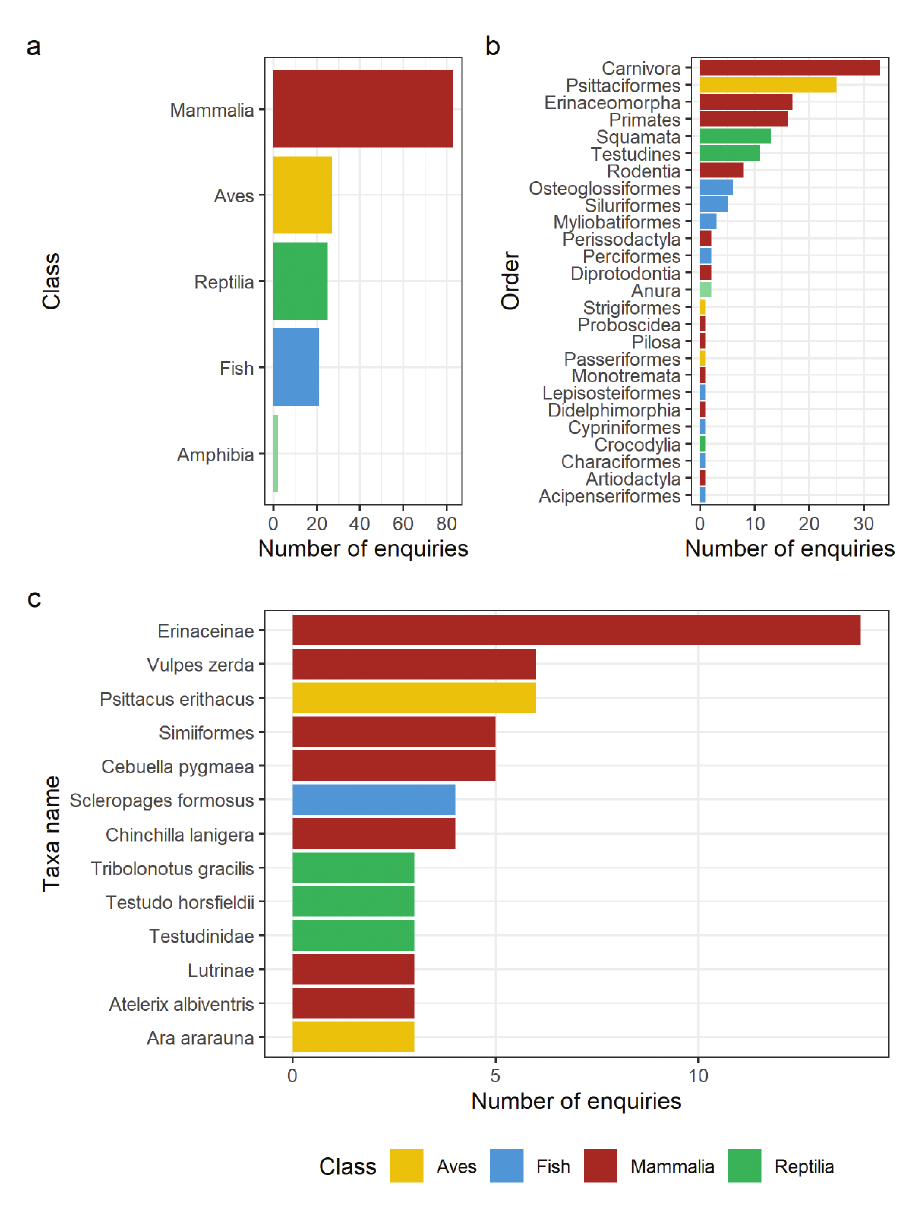
Figure 3. The number of enquiries by taxonomic class ( a ) and order ( b ) and highest taxa specified ( c ), excluding invertebrates. The subfamily Erinaceinae includes hedgehogs, Vulpes zerda is the fennec fox, Psittacus erithacus is the African grey parrot, order Simiiformes refers to monkeys, Cebuella pygmaea is the pygmy marmoset, Scelropages formosus is the Asian arowana, Chinchilla lanigera is the long-tailed chinchilla, Tribolonotus gracilis is the red-eyed crocodile skink, Testudo horsfieldii is the Russian tortoise, the family Testudinidae includes tortoises, the family Lutrinae include otters, Atelerix albiventris is the four-toed hedgehog and Ara ararauna is the blue-and-yellow